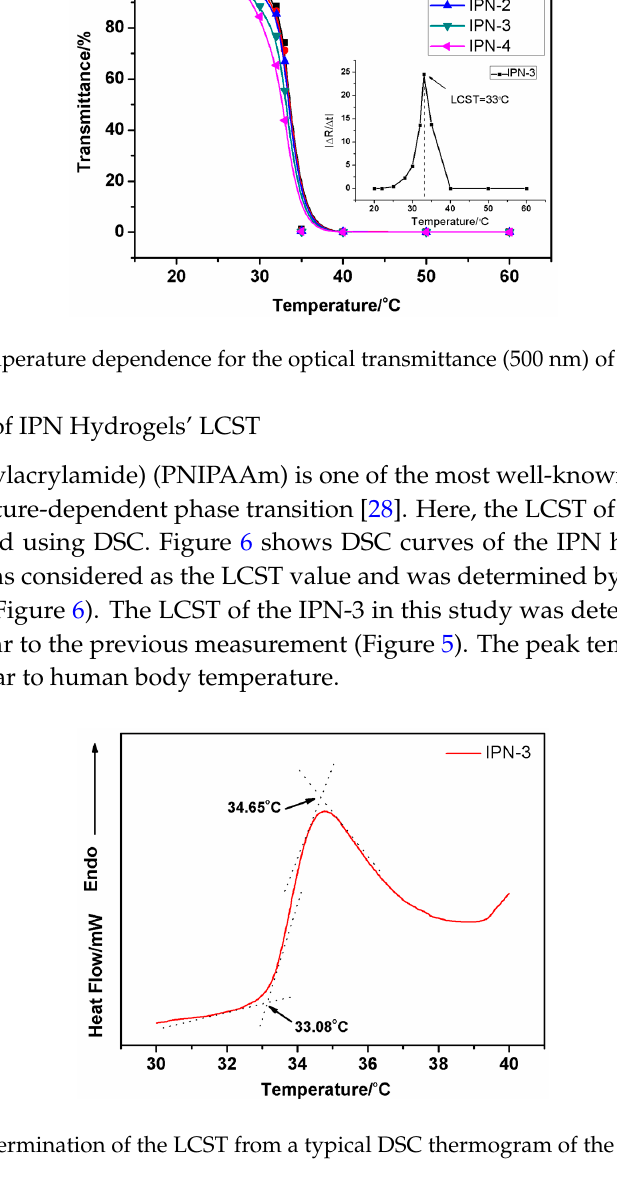
Table 2. Grafting degree of cotton fabric.